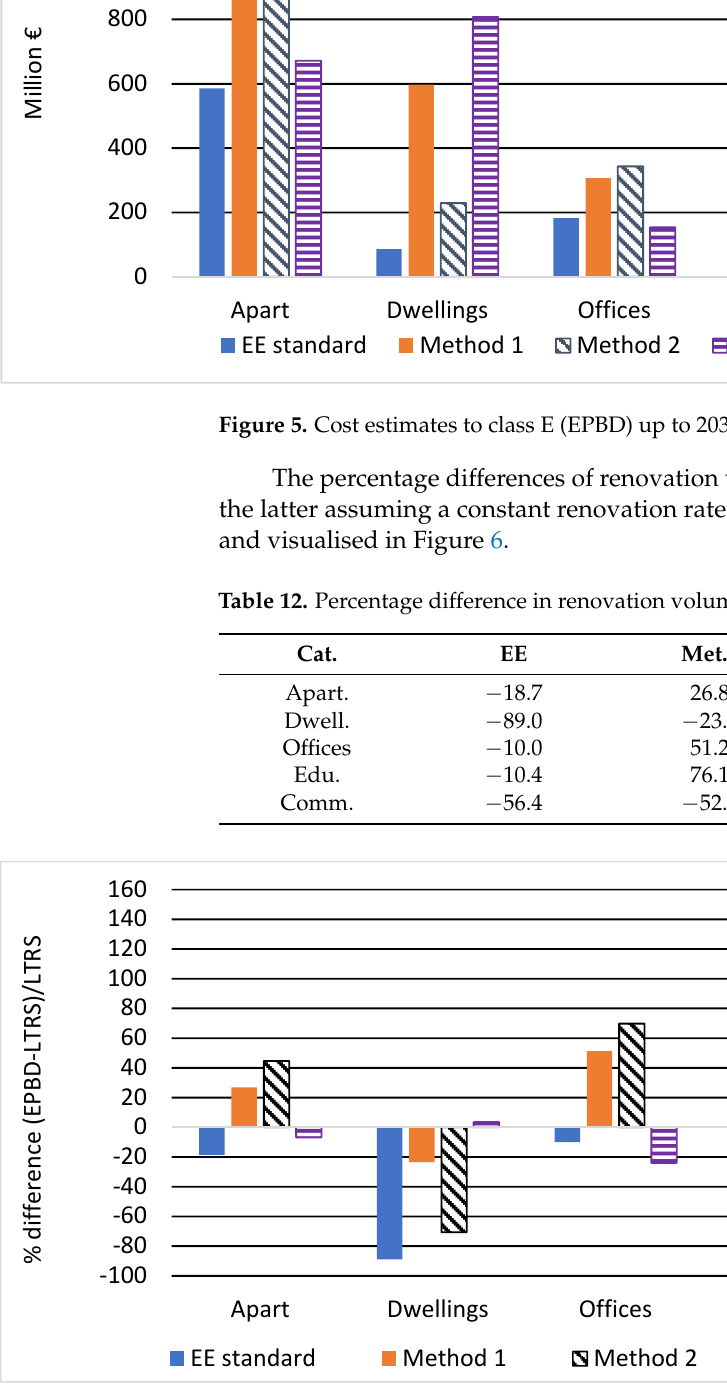
Figure 6 . Percentage difference of cost estimates to 2033 between EPBD and class C ambition in 2050 (LTRS).